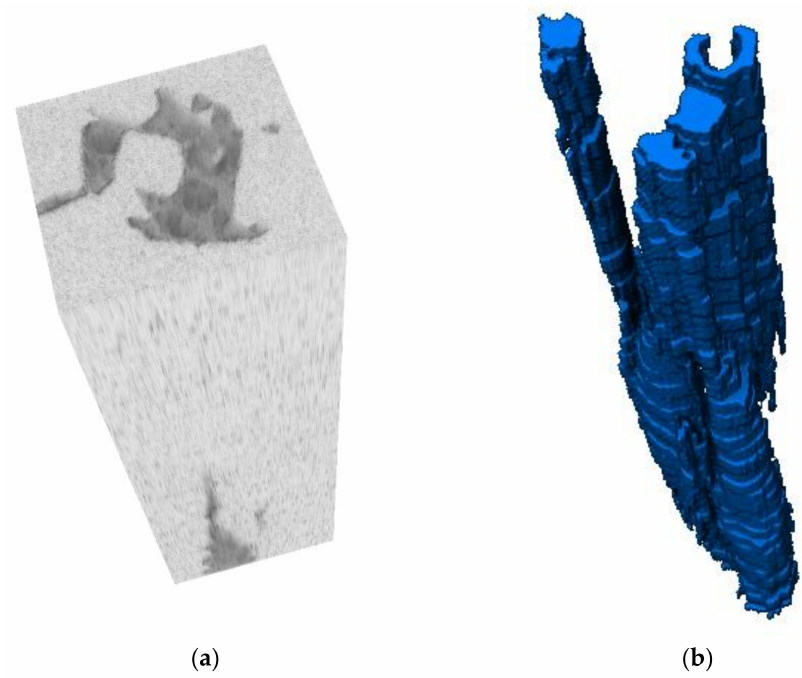
Figure 3. Pore structure extracted by CT scanning. ( a ) Three-dimensional reconstruction image of shale core; ( b ) extracted pore